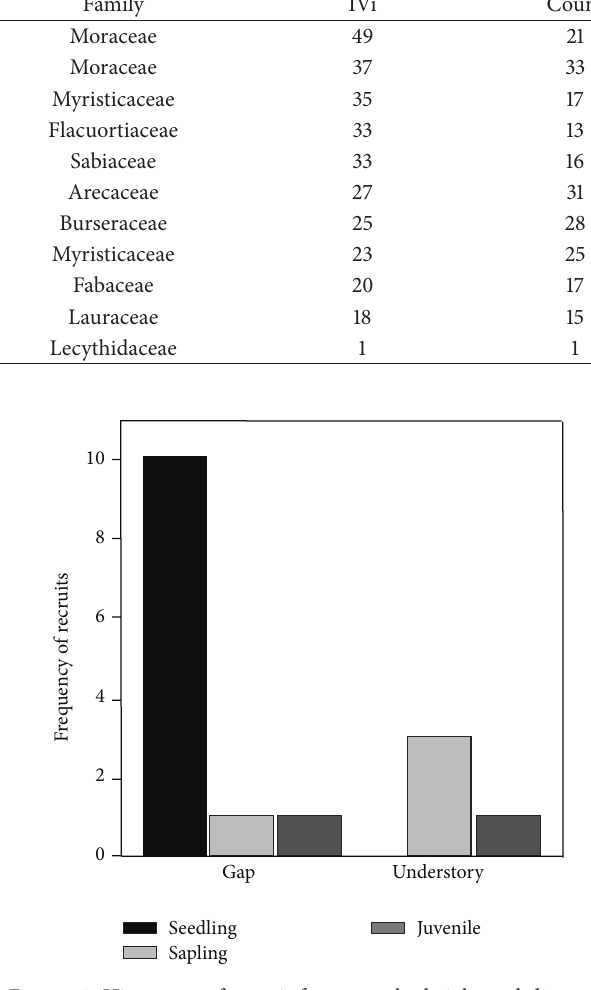
Figure 1: Histogram of recruit frequency by height and diameter at breast height (dbh) in gap and understory Sites. Size